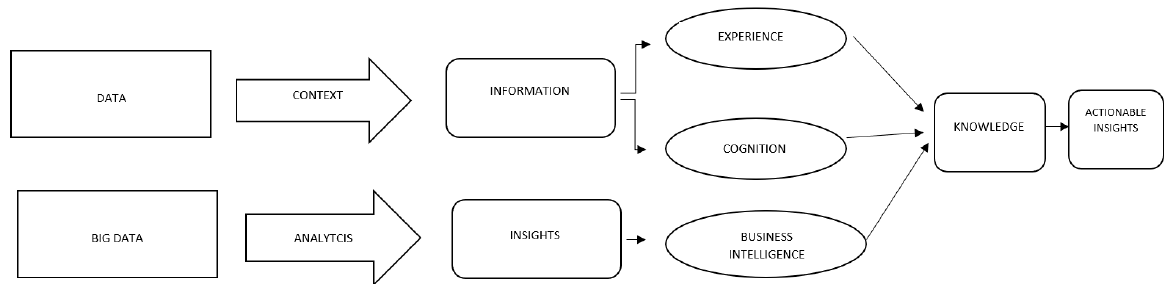
Figure 2. The convergence of information management and big data analytics.